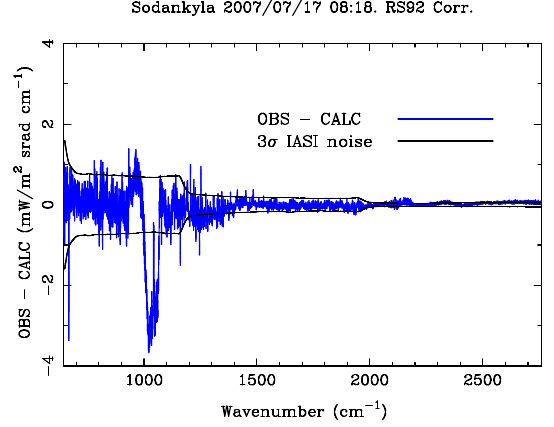
Figure 6. IASI observed minus calculated radiances (OBS-CALC) for the “RS92 Corr.”